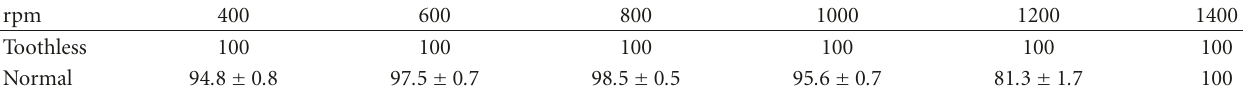
Table 4: The same as in Table 3, but now for gears working under